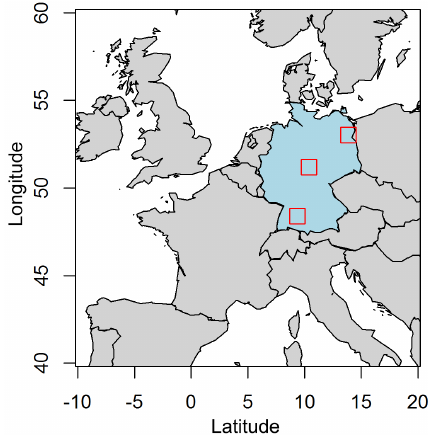
Figure 1. Location of the study sites (red squares) within Germany (light blue); southwest: Schwäbische Alb; center: Hainich–Dün; northeast: